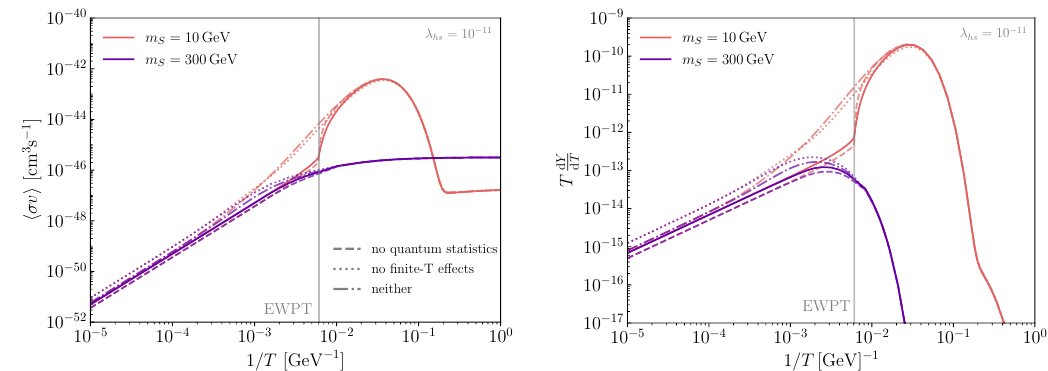
Figure 4 . Thermally averaged annihilation cross section (left) and the rate of change of the scalar singlet yield TdY/dT (right) for λ hs = 10 − 11 and m S = 10 GeV (red) and m S = 300 GeV (purple). Dashed, dotted and dash-dotted lines correspond respectively to the cases where we neglect quantum statistics, other thermal effects, or both. The grey vertical line indicates T = T EW